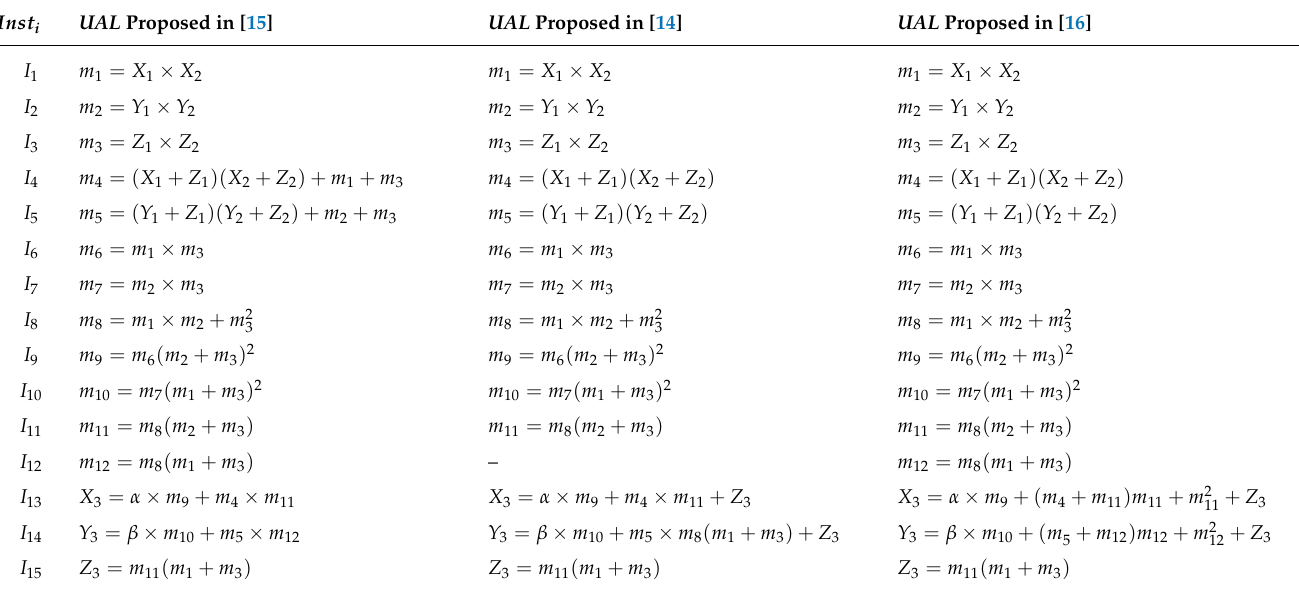
Table 1. Unified addition laws (UAL) of BHC model of ECC over GF ( 2 m ) .